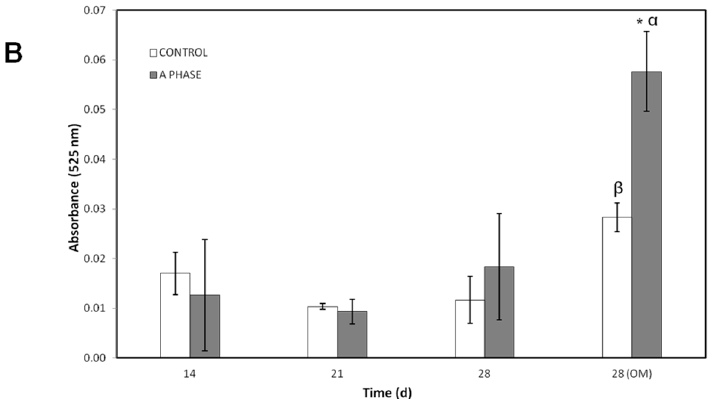
Figure 5. ( A ) AR-s images (×5 magnification) of the ah MSCs seeded as control in plastic and cells grown in indirect contact with Nurse’s-A phase ceramic after 14 days, 21 days, 28 days with GM and 28 days in OM; ( B ) AR-s quantification of the cells seeded in indirect contact with A phase compared to control cells growing on plastic without the presence of the material. (*) denotes significant differences ( p < 0.05) between A phase and control at the same experimental time; ( α ) denotes significant differences ( p < 0.05) between different experimental times obtained for control samples; ( β ) denotes significant differences ( p < 0.05) between different experimental times obtained for cells growing in indirect contact with Nurse’s A-phase scaffolds.